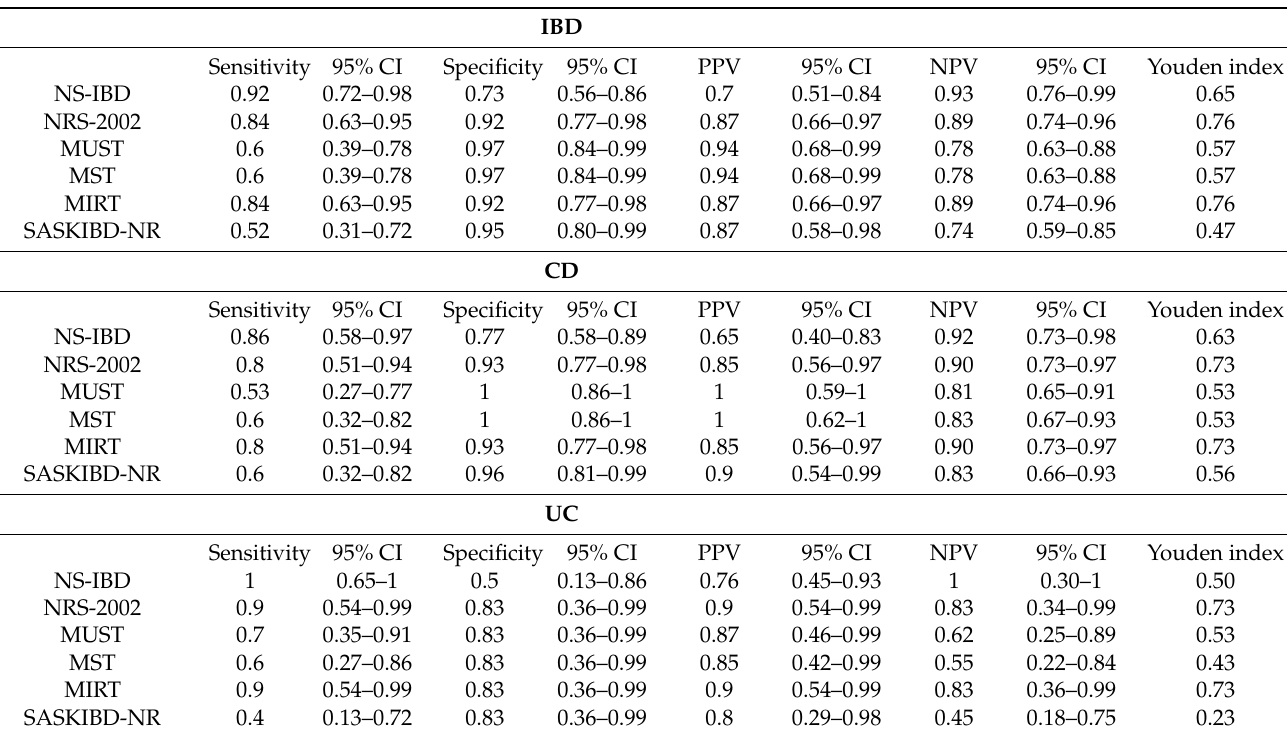
Table 5. Prevalence of high nutritional risk and malnutrition diagnosis in IBD, CD and UC patients.